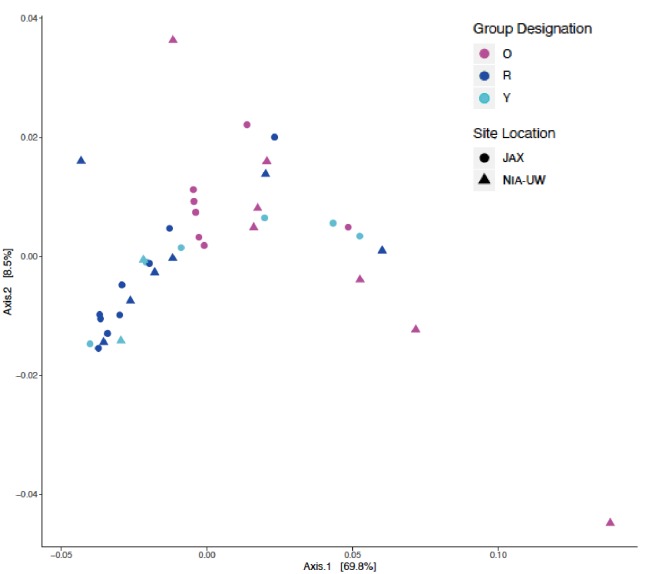
Combined beta diversity for JAX and NIA-UW animals by principal coordinate analysis using weighted unifrac distances by site location and group designation.No distinct differences in clustering by site location was observed. A PERMANOVA (nperm = 999) analysis was performed using the Adonis package (v 2.5–6) as part of the R suite comparing site location (JAX, NIA-UW) and group designation (Y = Young, O = Old, R = Old + Rapa) between JAX and NIA-UW mice used in this study via Bray Curtis Distances (p=0.341).